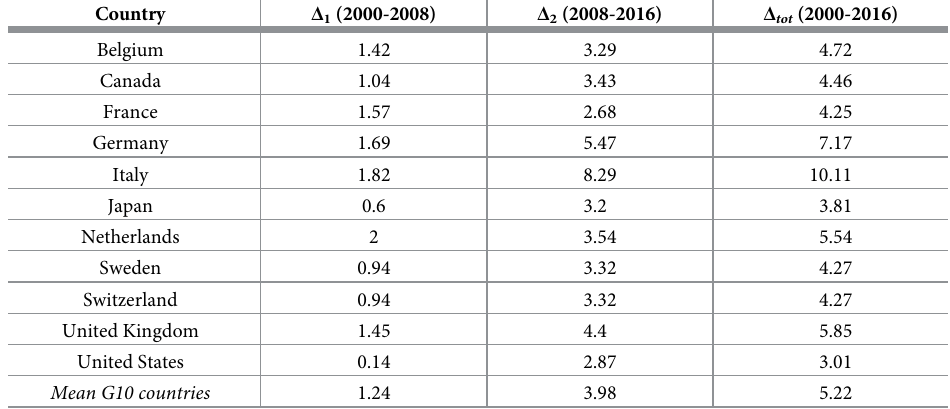
Table 1. Inwardness delta. Delta is calculated as simple difference (p.p.) between the inwardness in the last and the first year of the period.